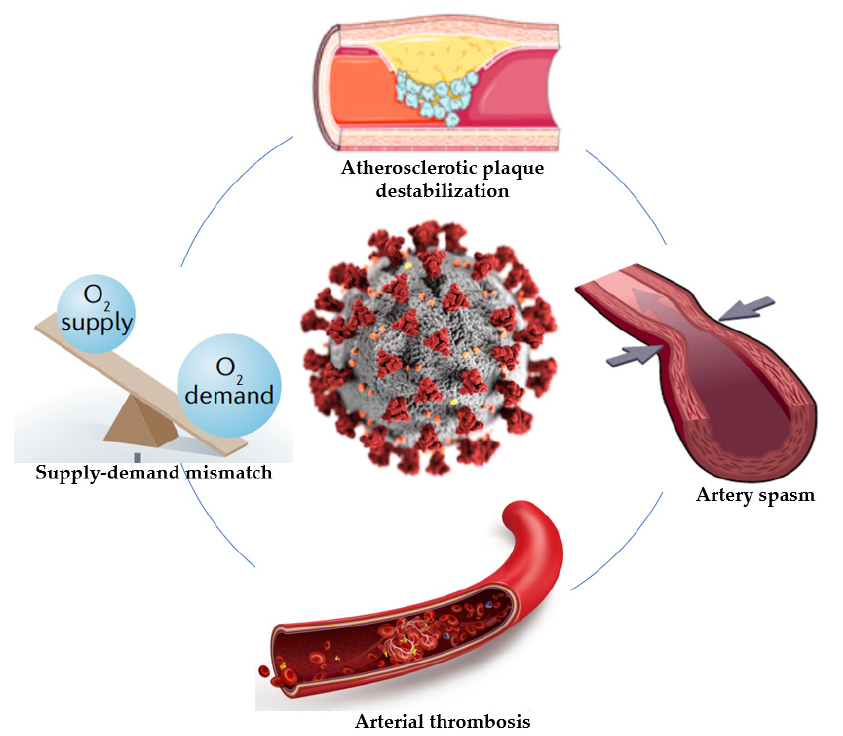
Figure 2. Possible mechanisms associated with myocardial infarction in patients with COVID-19.